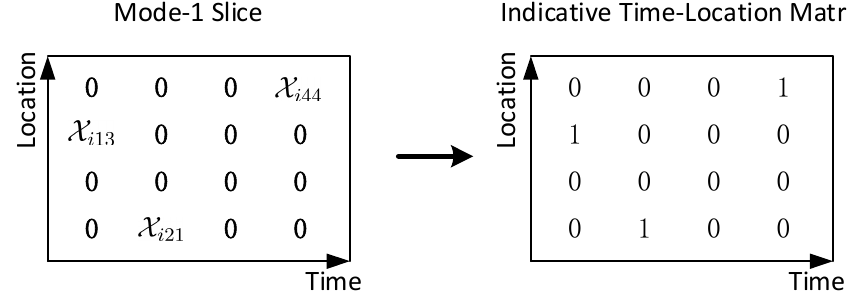
Figure 6. A toy example of mode-1 slice X i : : and the corresponding indicative time-location matrix for object i .